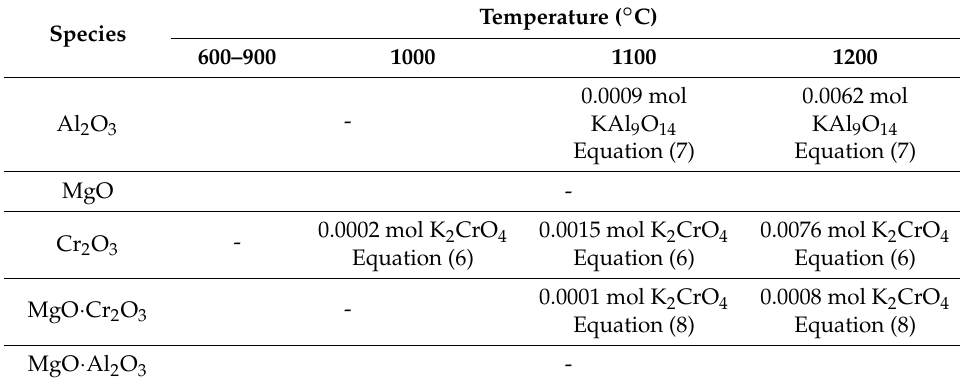
Table 2. Corrosion products and reaction equations of K 2 SO 4 reacting with the five components of refractory materials.